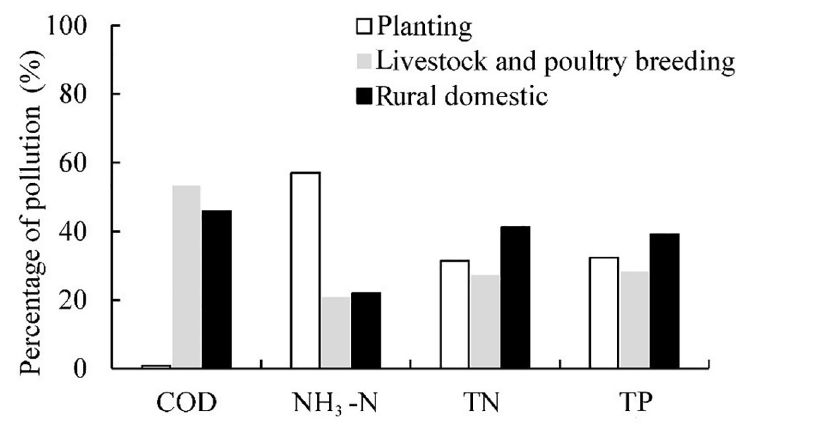
Fig 3. The contribution percentages of different potential pollution